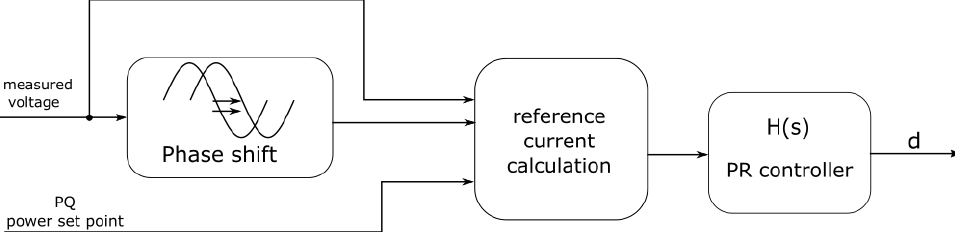
Figure 5. Current control loop implemented at each CSI